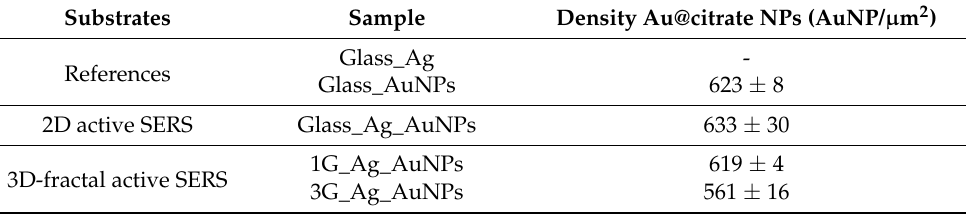
Table 1. Main characteristics of the SERS substrates and reference samples studied in this work.